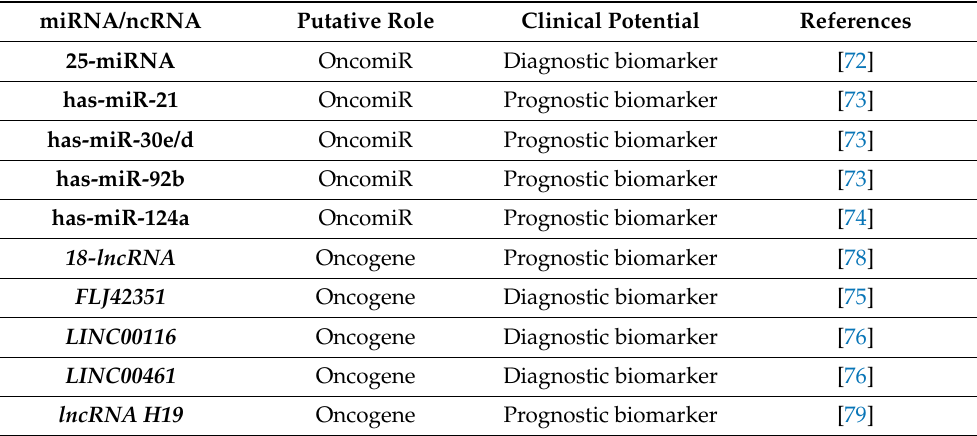
Table 1. Clinical potential of miRNAs/lncRNAs in